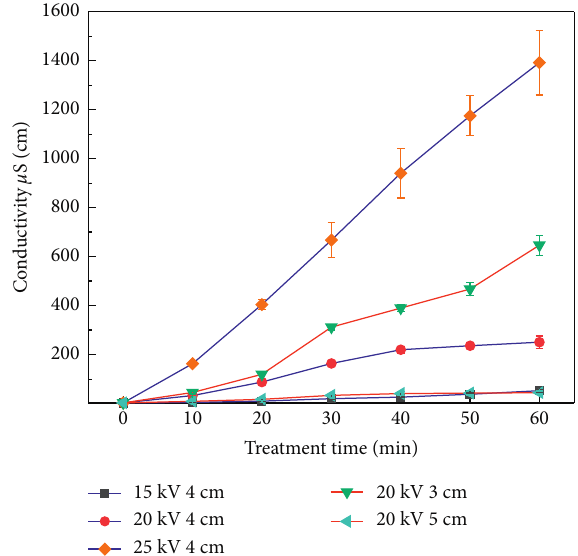
Figure 9: Conductivity values at needle-dielectric plate distance of 4cm and voltages of 15, 20, and 25 kV and needle-dielectric plate distance of 3 and 5cm and voltage of